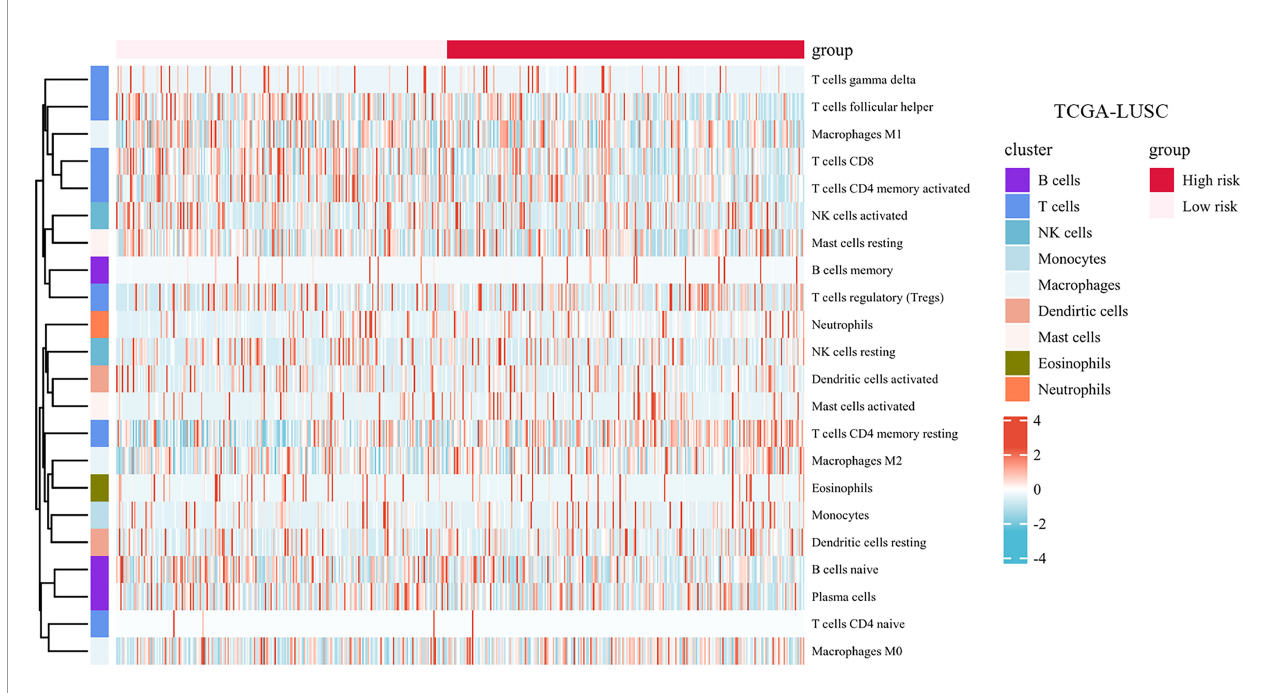
FIGURE 8 | In fi ltration of immune cells among high-risk groups versus low-risk